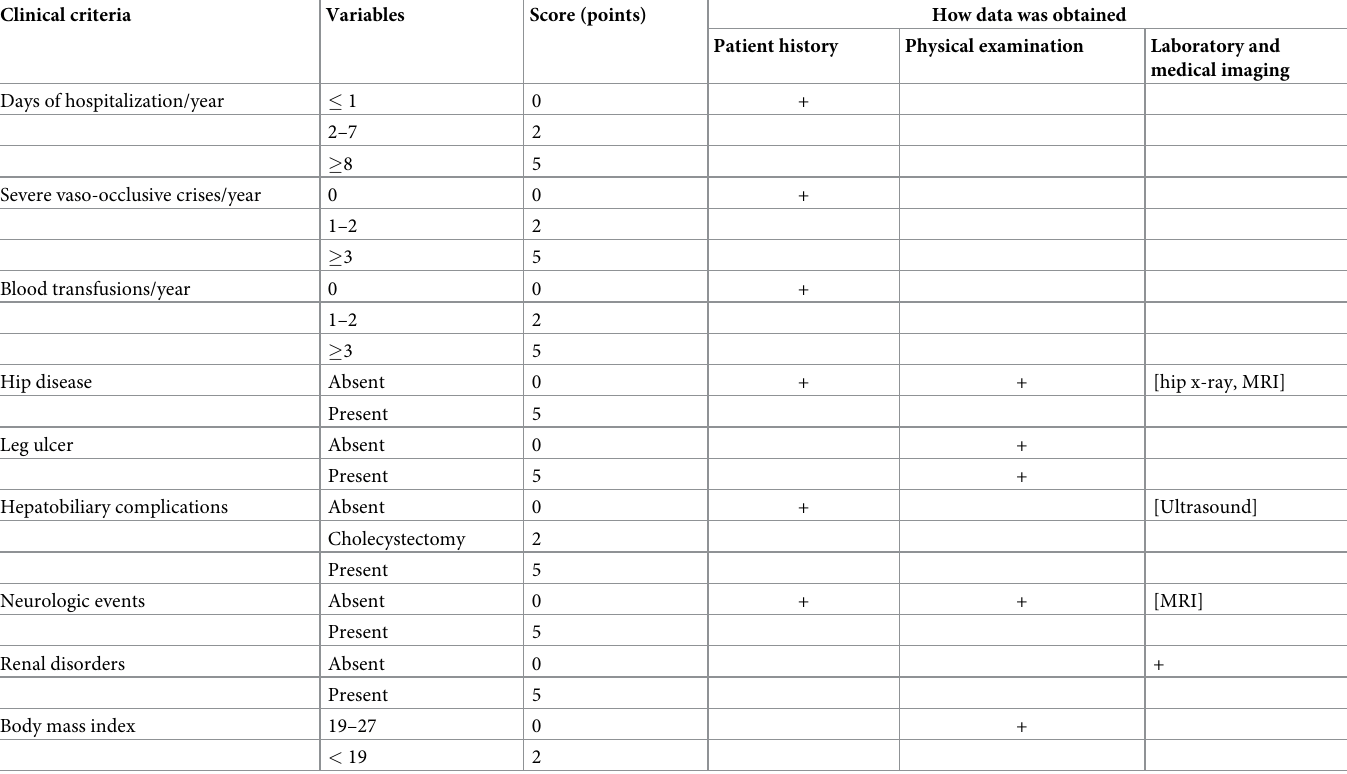
Table 1. Clinical criteria and severity score based on the phenotype (reproduced from Mikobi et al.) [14]. Clinical